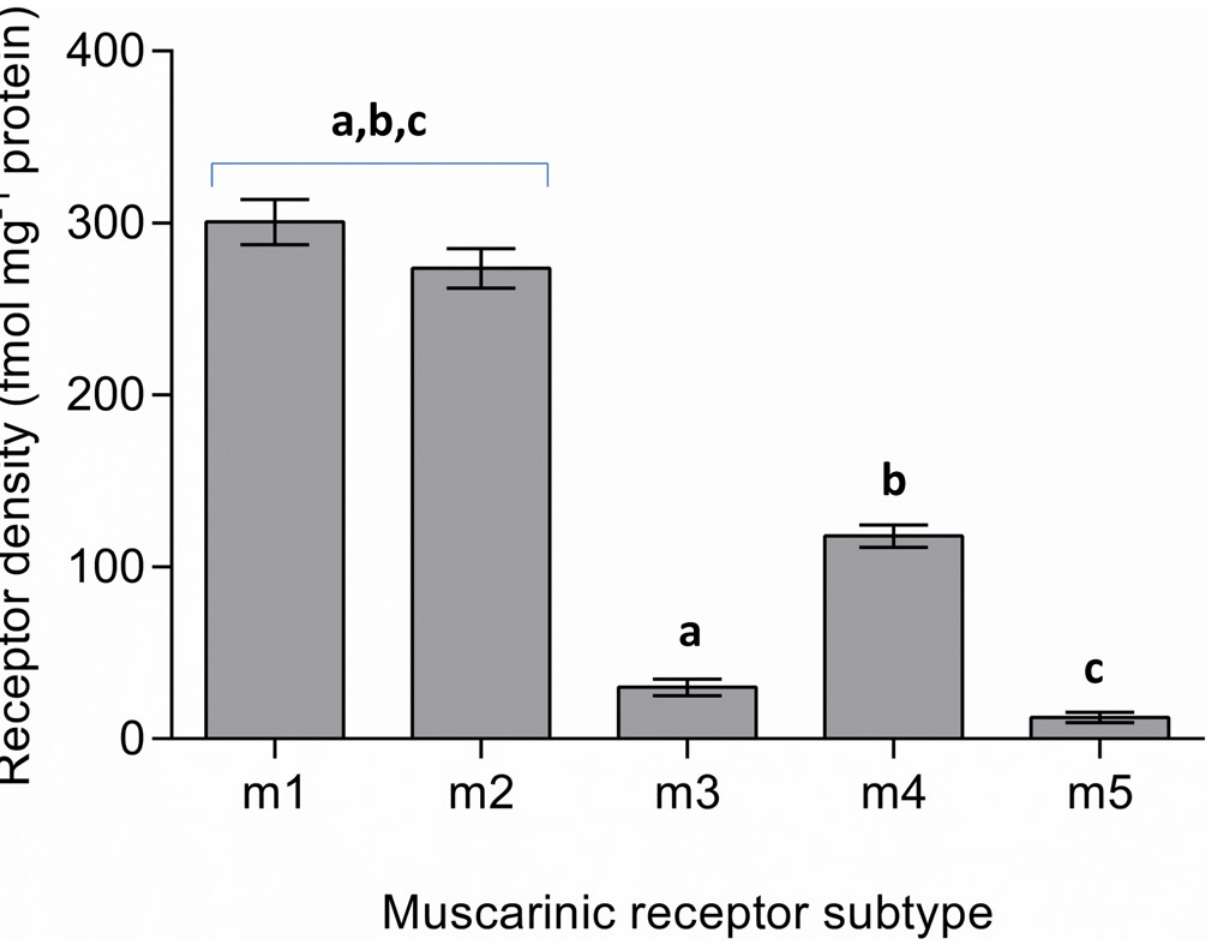
Fig 4. Quantitative analysis of muscarinic acetylcholine receptors (mAChR): receptor concentration (fmol mg-1 protein) values were determined using sandwich ELISAs for each subtype. Bars represent the mean ± SEM of the means from three separate experiments: Values marked ‘ a ’ , ‘ b ’ or ‘ c ’ are significantly different from each other (P < 0.001). Additionally, values for m3 and m5 are significantly different from those of m4 (P < 0.001), whilst values for m3 and m5 are also significantly different from each other (P <